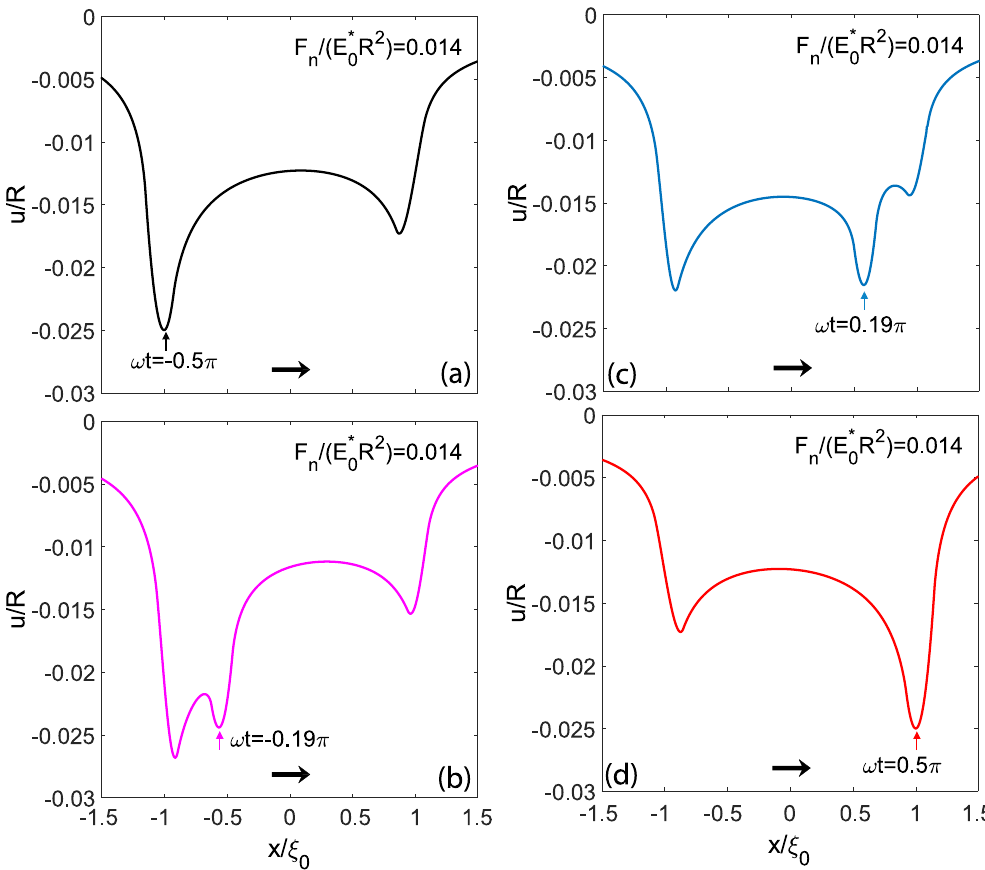
Figure 2. The dimensionless normal displacements = u x y R ( , 0)/ as a function of the dimensionless abscissa ξ x / in the case of the reciprocating motion of a sphere over a viscoelastic half-space. Calculations are carried 0 2 out for a given normal force = . ⁎ F R E / 0 014 , an amplitude ξ = R / 1 and several values of the dimensionless n 0 0 time ω π π ∈ − t [ /2, /2]